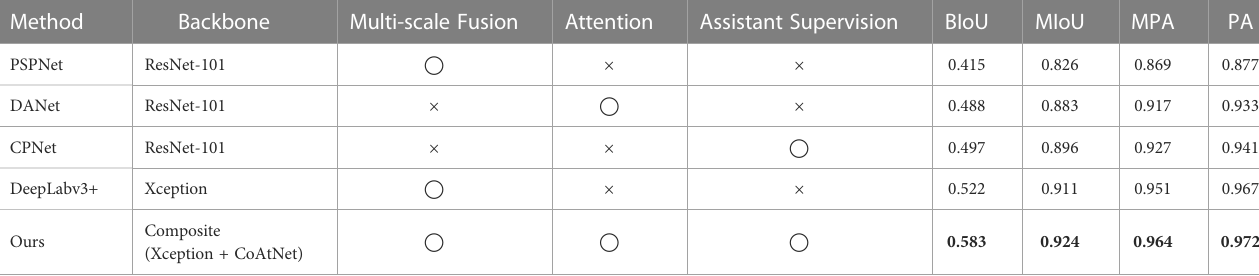
TABLE 3 The performance of segmentation Models in training from scratch.